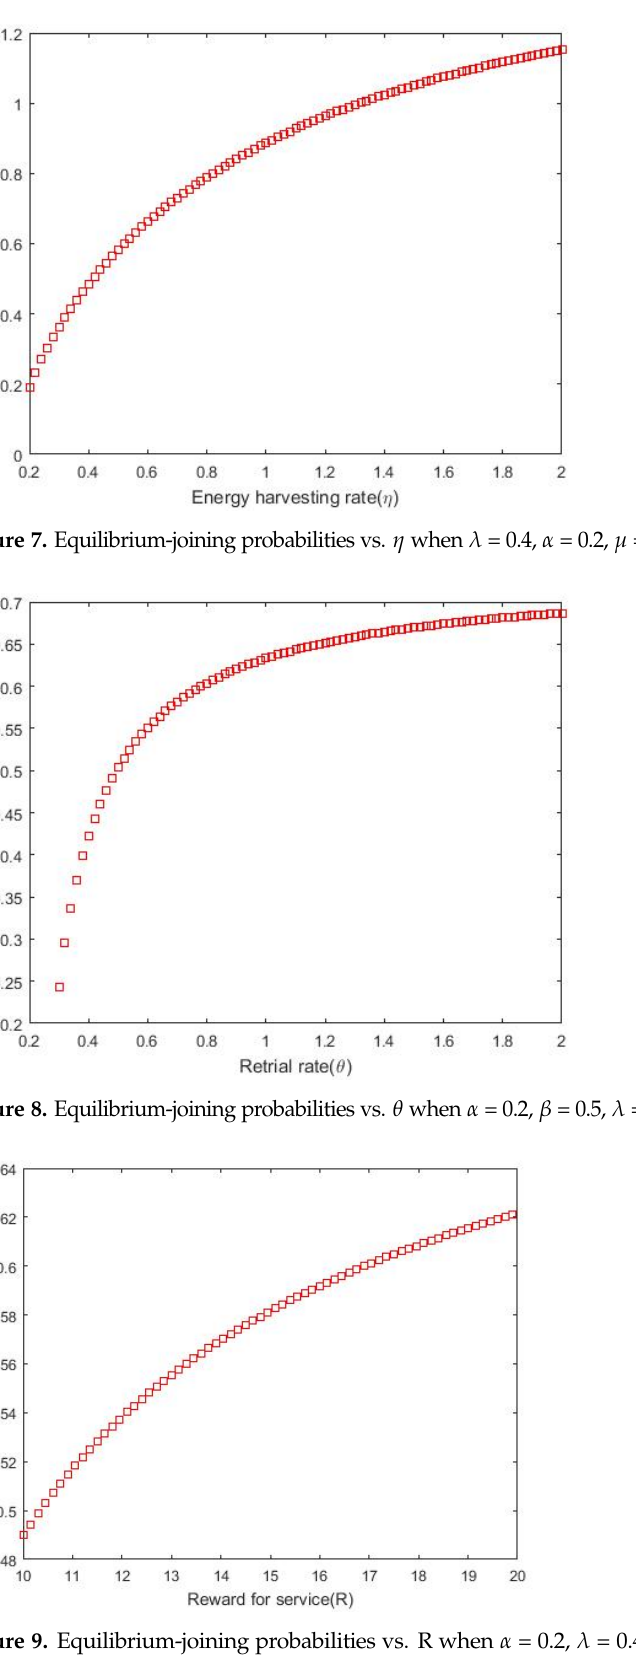
Figure 9. Equilibrium-joining probabilities vs. R when α = 0.2, λ = 0.4, µ = 1, β = 0.5, θ = 0.7, η = 0.5, C =